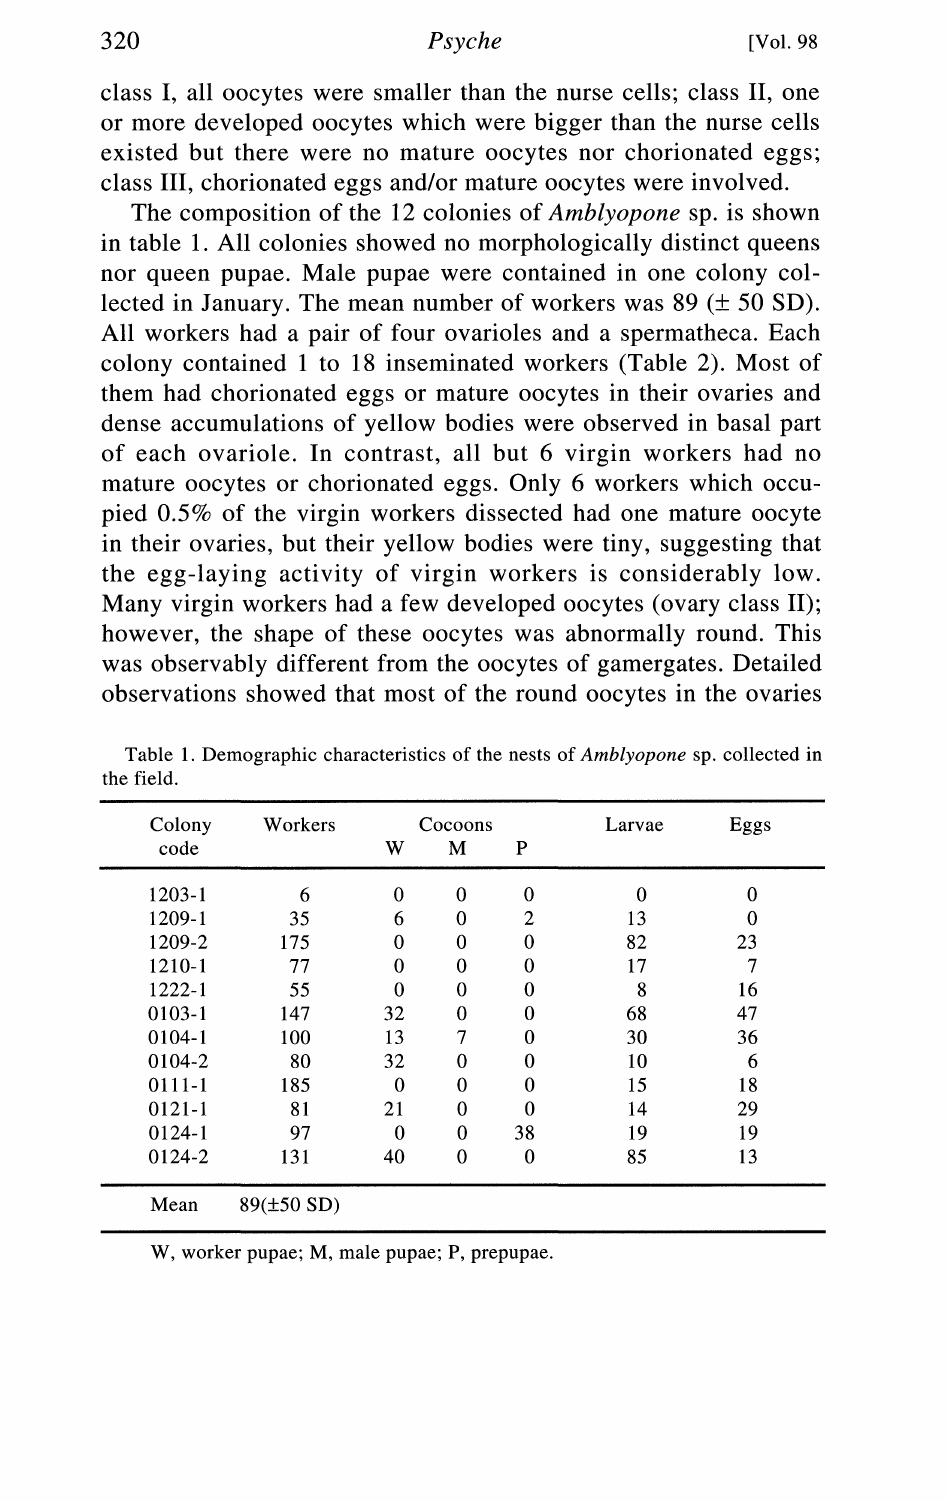
Table 1. Demographic characteristics of the nests of Amblyopone sp. collected in the field. Colony Workers Cocoons Larvae Eggs